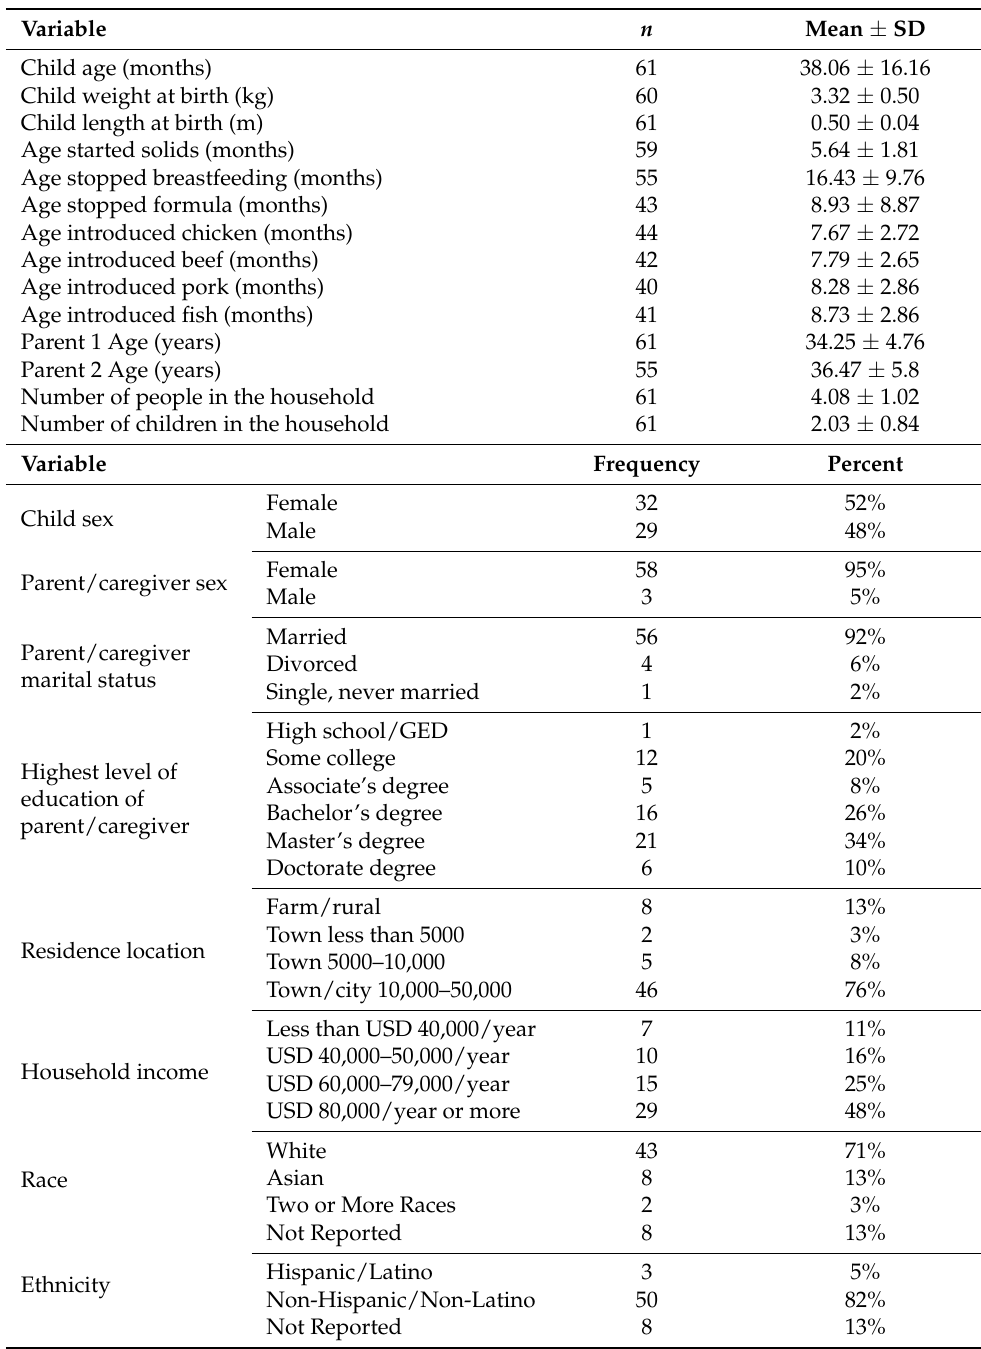
Table 2. Subject characteristics. SD indicates standard deviation ( n =